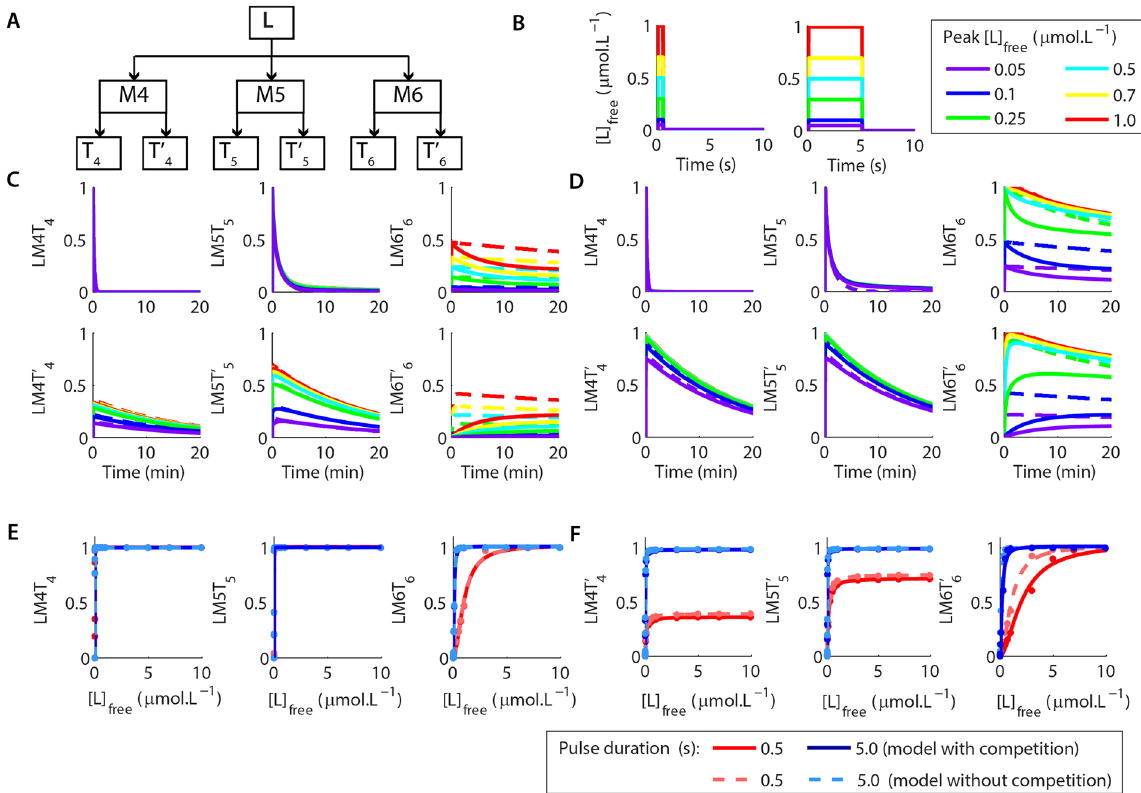
Figure 8. The role of competition in the detection and discrimination of dynamic signals. ( A ) The simulated system consisted of 3 targets activated by L (M4, M5, and M6) forming the complex LM4, LM5 and LM6. Each complex activated two substrates in a competitive manner. ( B ) We used pulses of [L] free with different durations (0.5 and 5 s) and peak concentrations to verify the role of competition in the activation of the targets of LM4, LM5, and LM6. ( C,D ) The results obtained showed that competition did not affected the peak activation of fast- reacting targets (LM4T 4 , LM5T 5 , LM6T 6 ) for pulses of [L] free with 0.5 s ( C ) or 5 s ( D ) of duration in comparison to the results without competition (dashed lines). However, the presence of competition impaired the peak activation of slow reacting-targets (LM4T ′ 4 , LM5T ′ 5 , LM6T ′ 6 ), promoting a slightly reduction in the peak amplitude of their dose-response curves of activation and a shift in their values of K Dapp ( E-F ), which became larger (Suppl. Table